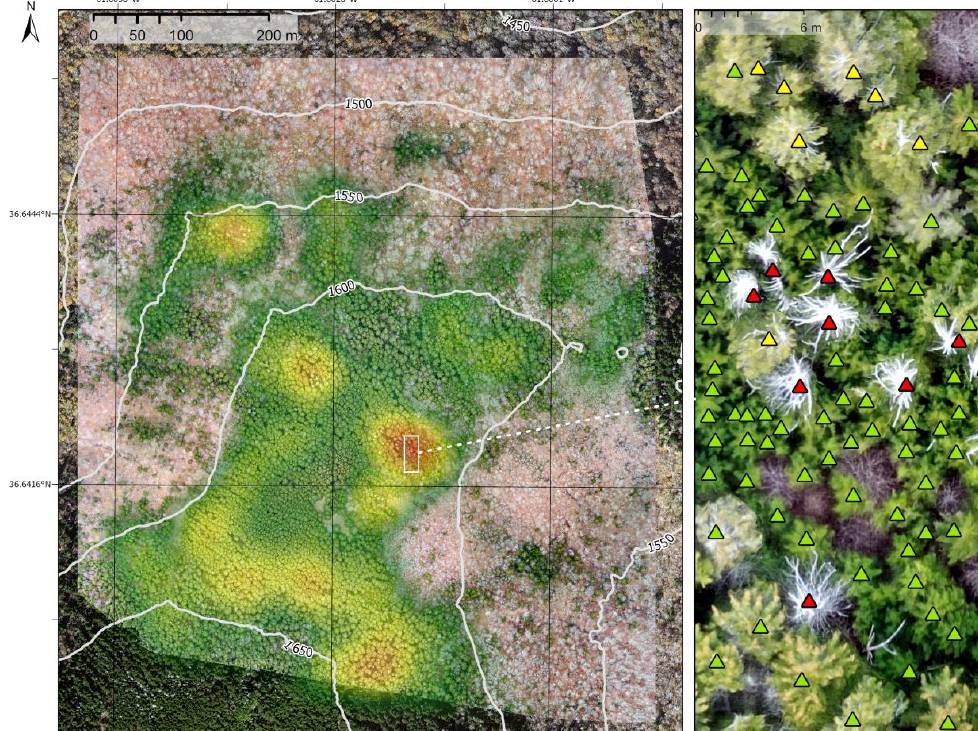
Figure 4. Left : Kernel density map of only dead and declining spruce points within the Whitetop sample plot with green-yellow-red color ramp; green and red indicate low and high concentrations of dead/declining spruce, respectively. A 2.5 m resolution pixel size was set to represent the approximate horizontal area of spruce. Triangles (see right close-up) represent classified spruce: red = dead, yellow = declining, and green = live; contour lines in meters above sea